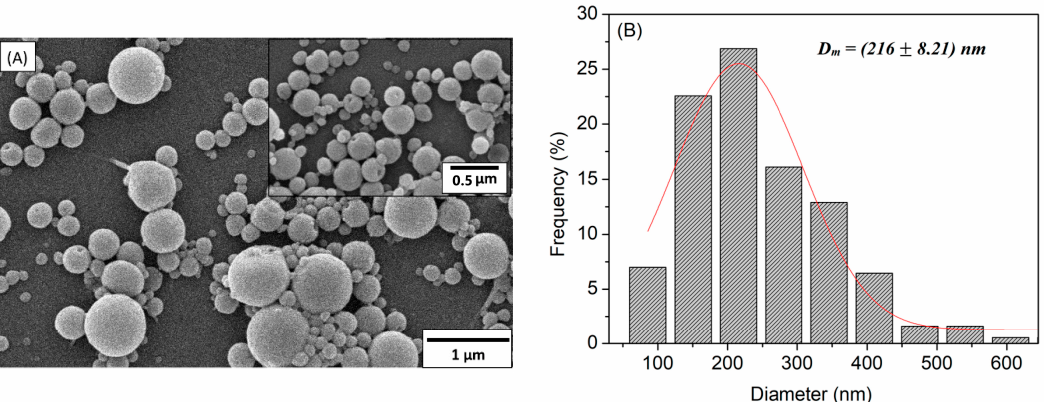
Figure 2. ( A ) Scanning electron micrographs of the cellulose acetate nanoparticles (CA-NPs) with an increase of × 20,000 and zoom of × 50,000; ( B ) histogram with a large distribution from 100 to 600 nm, with average diameter values of around 216 ± 8.21